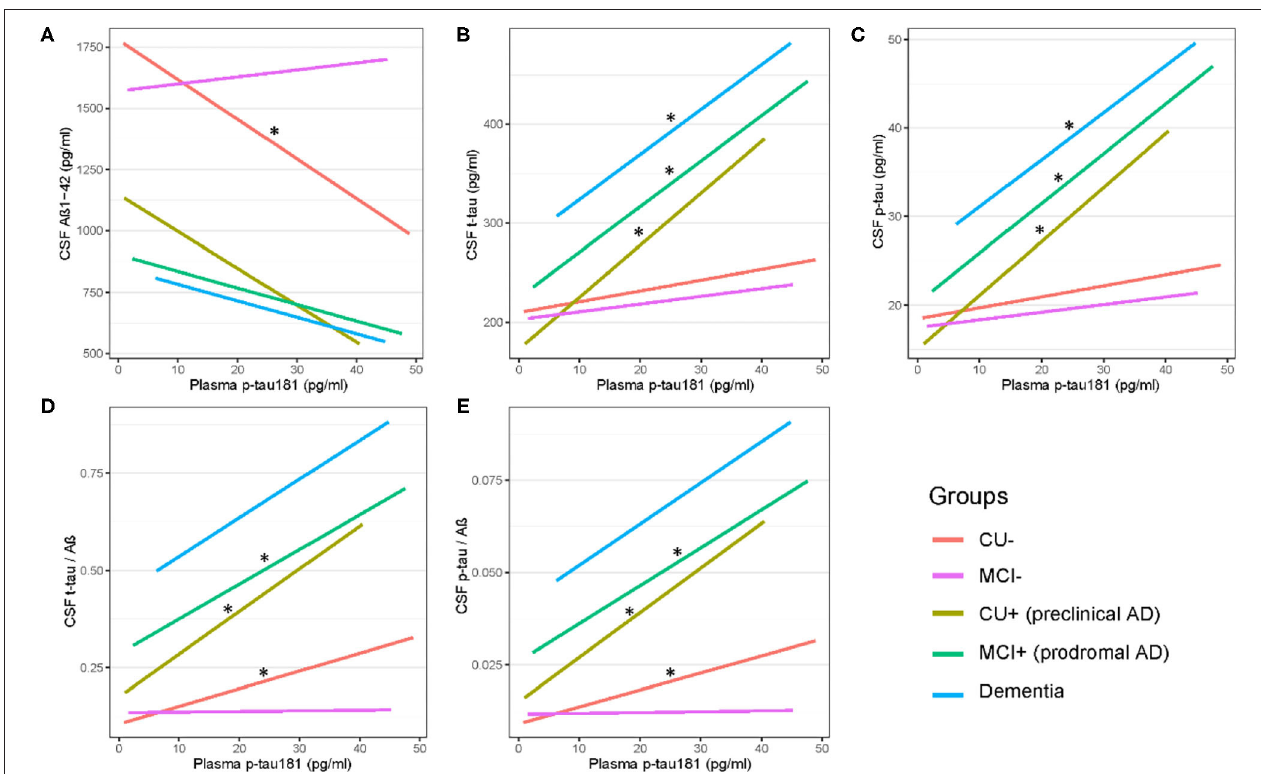
FIGURE 2 | (A–E) Cross-sectional associations of plasma p-tau 181 with CSF biomarkers across AD dementia staging. Significant correlations are indicated by “*” ( p < 0.05). CU–, cognitively unimpaired with negative A β ; MCI–, mild cognitive impairment with negative A β ; CU + , cognitively unimpaired with positive A β ; MCI + , mild cognitive impairment with positive A β .